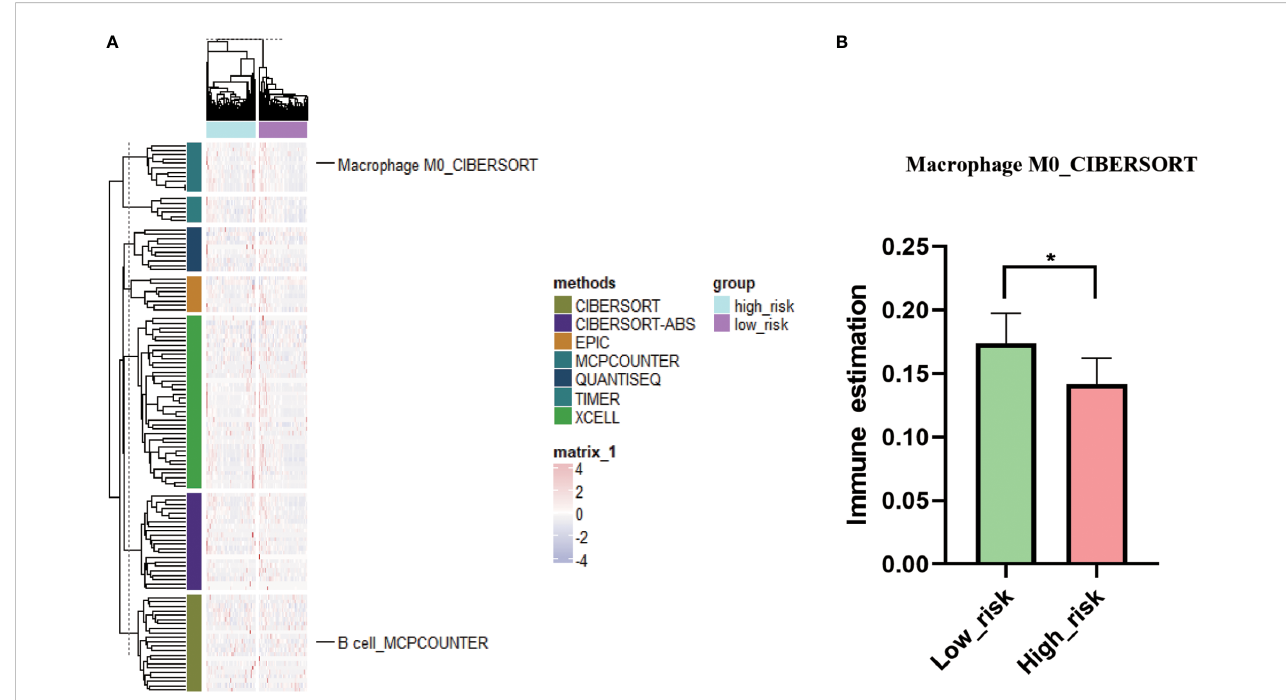
FIGURE 6 Immune status analysis in low- and high-risk groups. (A) : Complex heat map of immune estimation in low-risk group vs high-risk group. (B) : Comparison of immune estimates of macrophage M0 in low-risk group vs high-risk group. * P <